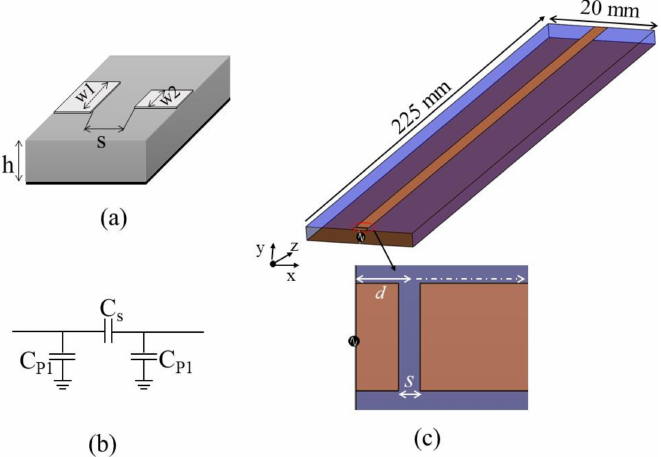
Figure 1. The model for the analysis ( a ) of gapped microstrips, ( b ) the circuit representation of the gapped microstrip, ( c ) the model of a gapped microstrip used for analysis of the effect of size and distance of the gap; the close-up image shows the variables s and